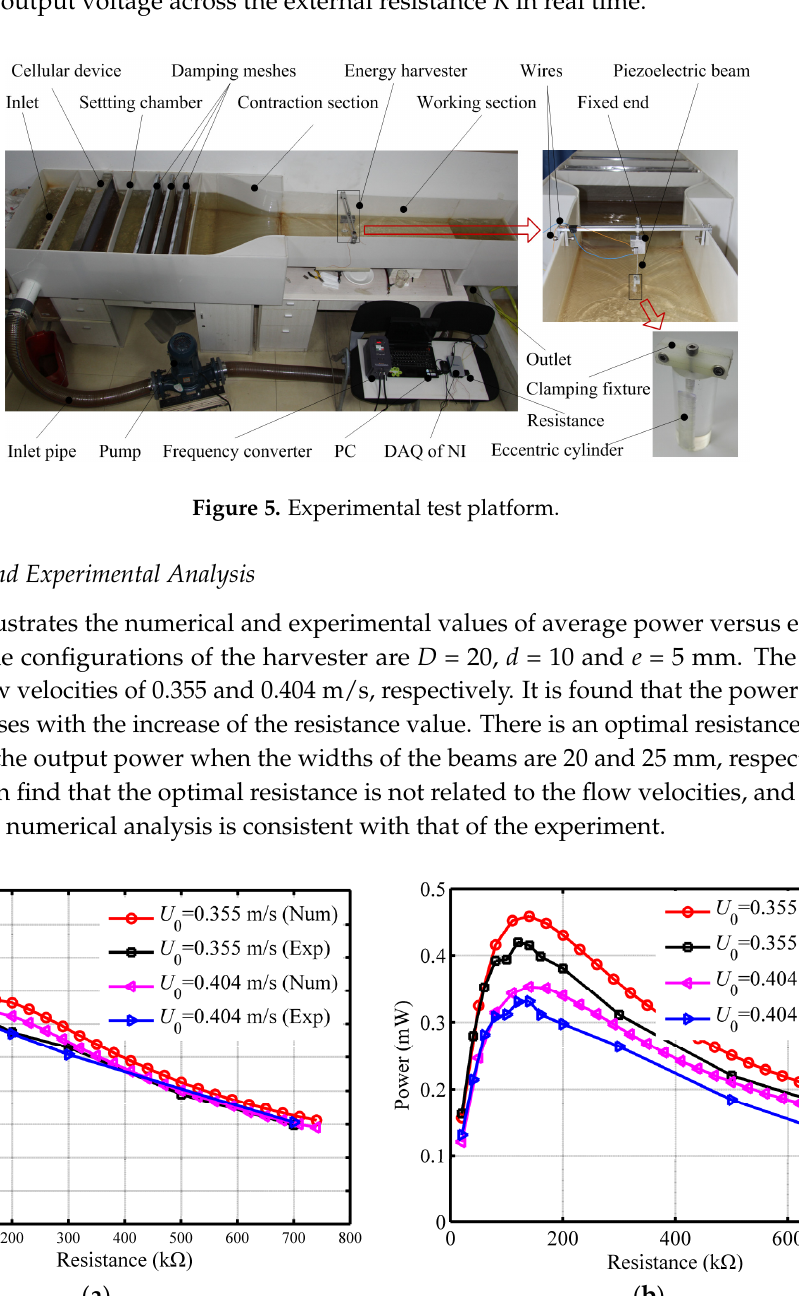
Table 2. Configurations of the eccentric cylinder.